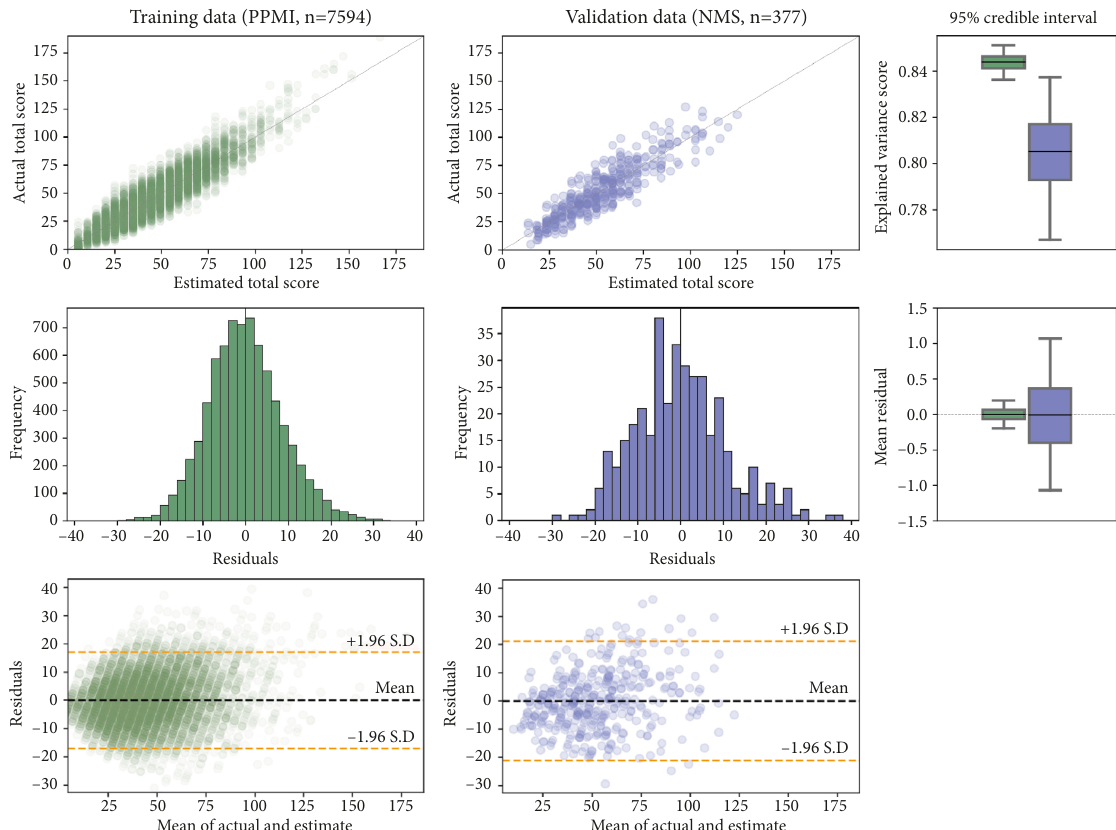
Figure 2: A linear regression model was used to estimate the total 50-item MDS-UPDRS rating (see Section 2.4), using the 8-item rating of the “remote” subset (see Table 1). (Upper left) The correspondence between ground truth and estimations for the training dataset, and (upper center) the validation dataset. Note: the X � Y line is marked in grey. For both datasets, the correlations between ground truth and estimations were highly significant ( p -value < 0.0001), and (upper right) the 95% credible intervals of these correlations overlapped. This suggests the ability of this 8-item subset to estimate the total 50-item MDS-UPDRS rating generalises across different datasets. (Mid left) The residuals of the estimator for the training dataset, and (mid center) the validation dataset. The mean residuals for both datasets were close to zero, and (mid right) the 95% credible intervals of the mean residual crossed zero for both datasets. This suggests the linear regression model is an unbiased estimator of the total 50-item MDS-UPDRS rating. (Lower left) The Bland–Altman plot of agreement between the actual and estimated total score for training (lower center) and validation, both of which show that residuals are approximately equally distributed either side of zero across the range of possible values of total score, indicating a lack of proportional